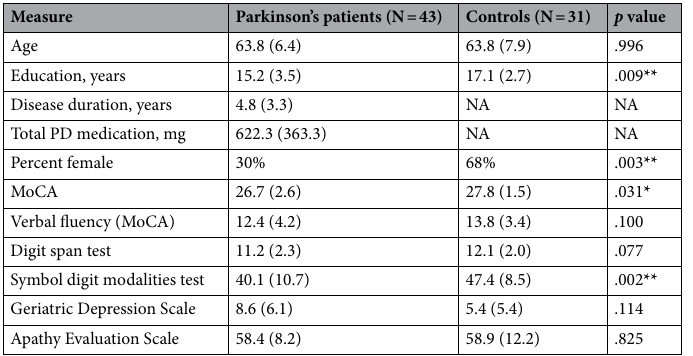
Table 1. Demographic and neuropsychological information. MoCA = Montreal Cognitive Assessment, verbal fluency is taken from the Language section of the MoCA. Values presented are mean (SD). * p < 0.05, ** p <